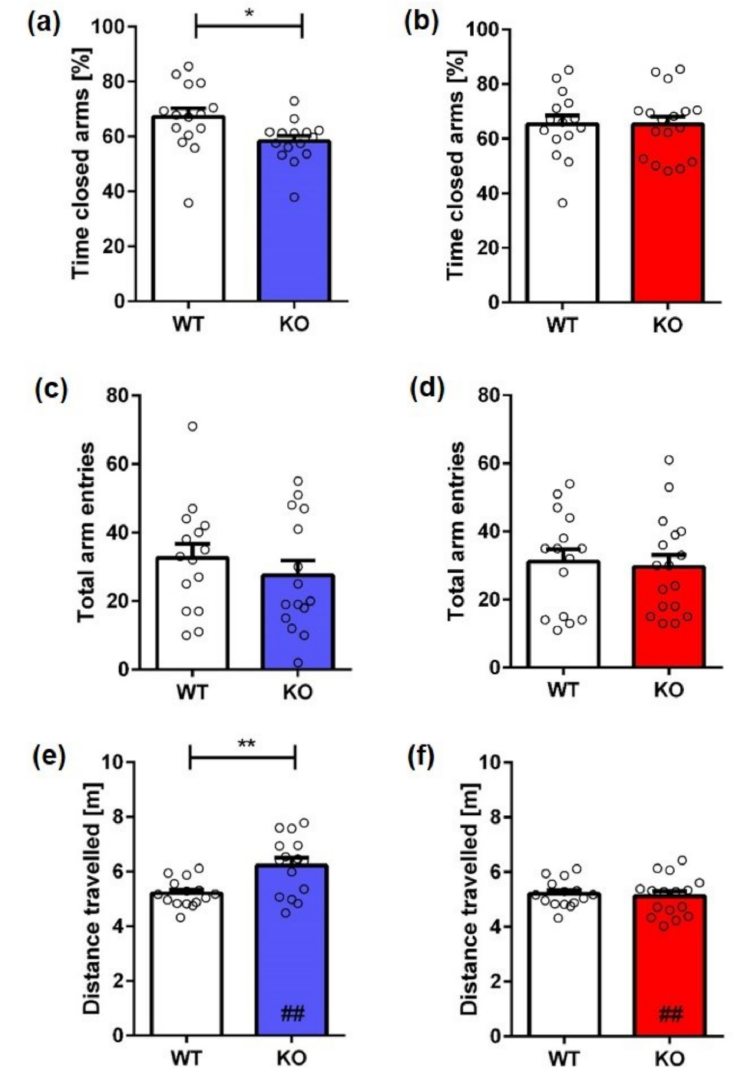
Figure 6. Exploration and anxiety behavior of Mover KO mice in the elevated plus maze. Male KO mice spent significantly less time in the closed arms of the maze ( a ) and traveled ( e ) significantly further than WT mice. In contrast, no significant differences in time spent in the closed arms ( b ) or distance traveled ( f ) were observed in female mice. The number of arm entries did not differ between male KO ( c ) or female KO ( d ) and same-sex WT animals. Unpaired t -test, n = 15–17. Data presented as mean ± S.E.M. * p < 0.05; ** p < 0.01 (genotype difference); ## p < 0.01 (sex